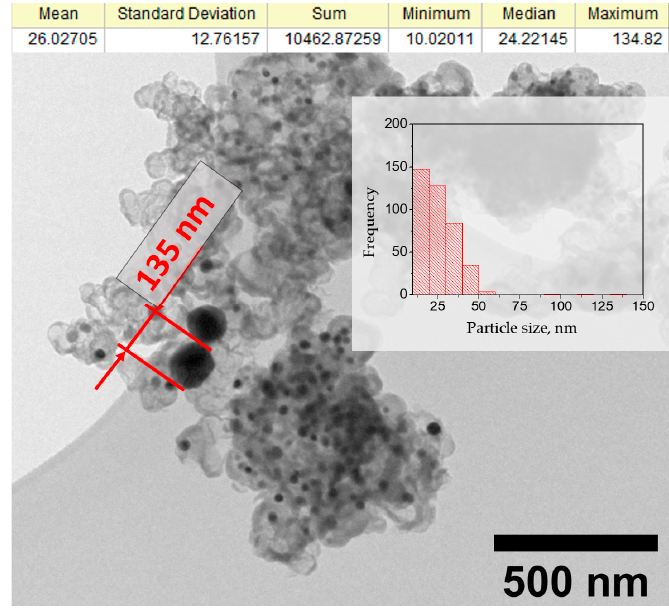
Figure 3. TEM image of the 10NiS450 catalyst.